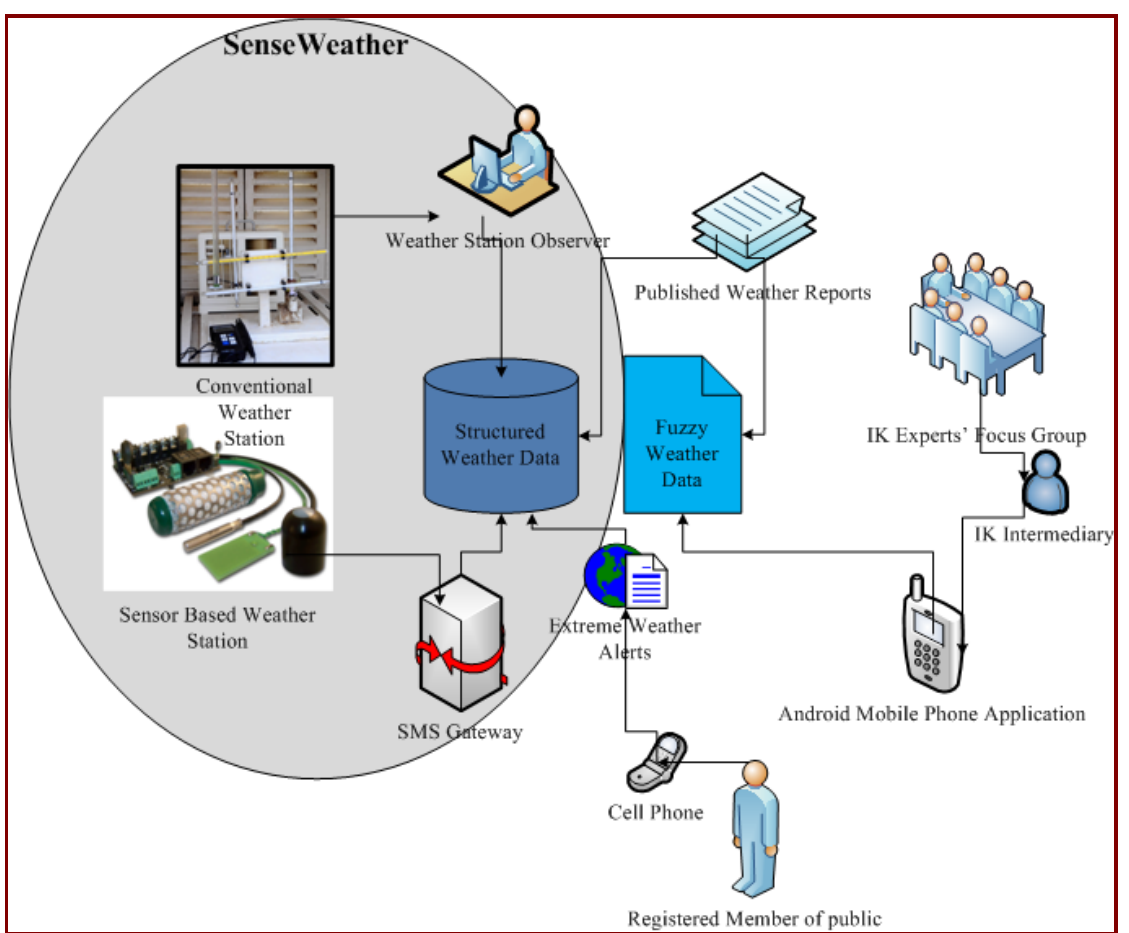
Figure 5. SenseWeather : system logic. IK, indigenous